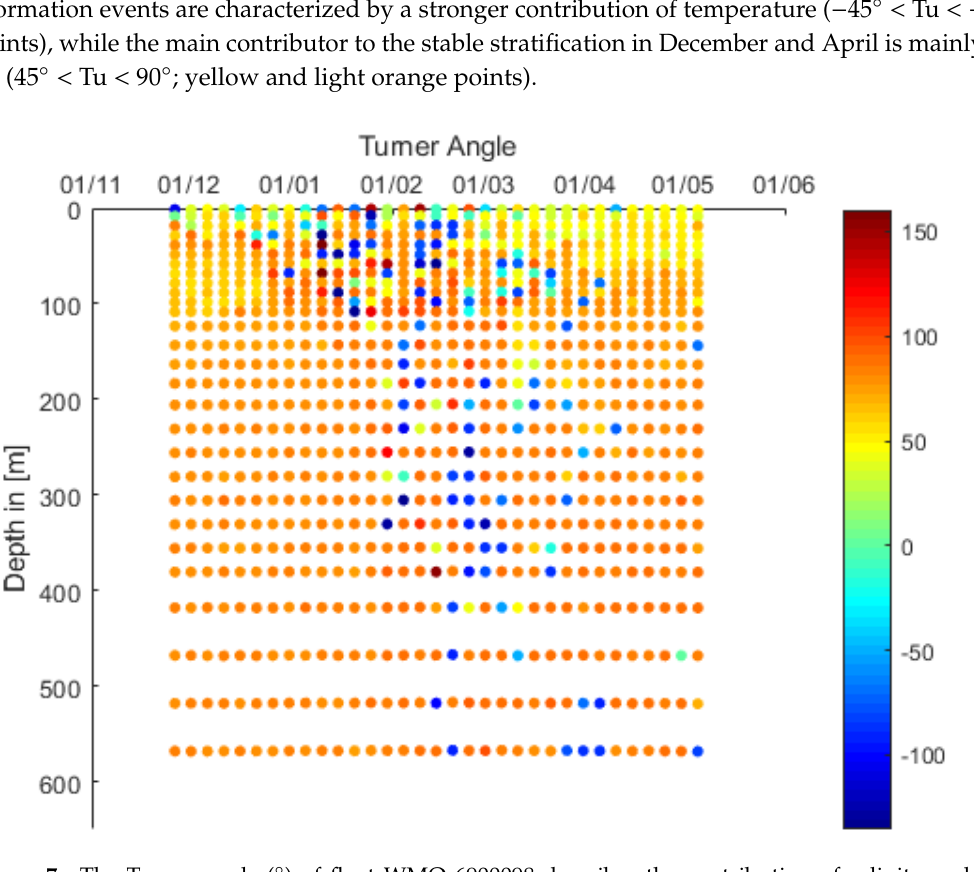
Figure 8. Upper panel: Time series of integrated daily surface heat fluxes from December 2005 to April 2006 for the center of Rhodes Gyre. The heat losses by the end of January and mid-February induced deep convection and formation of Levantine deep water (LDW) while the heat losses in